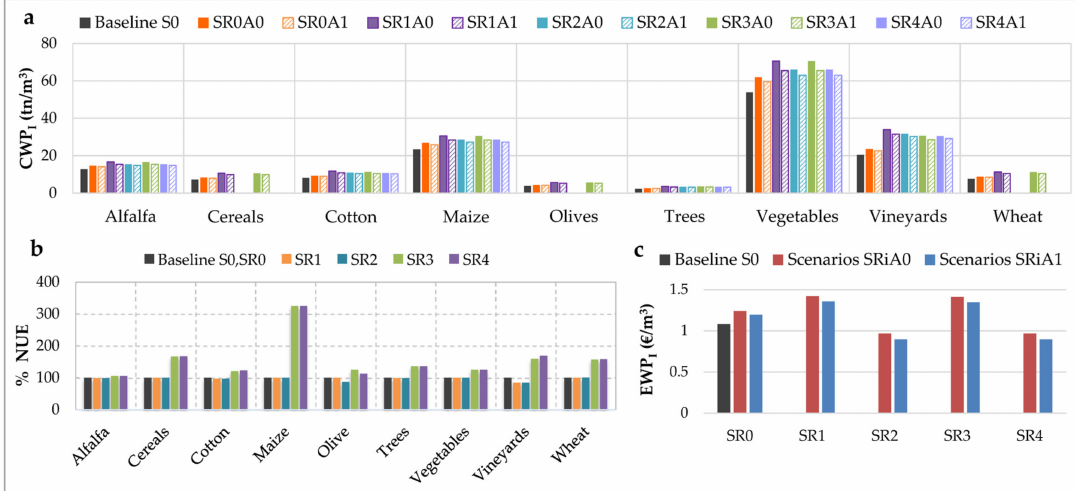
Figure 11. Annual average values of ( a ) Crop Water Productivity (CWP I ), ( b ) Nitrogen Use Efficiency (NUE), and ( c ) Economic Water Productivity (EWP I ) for the period